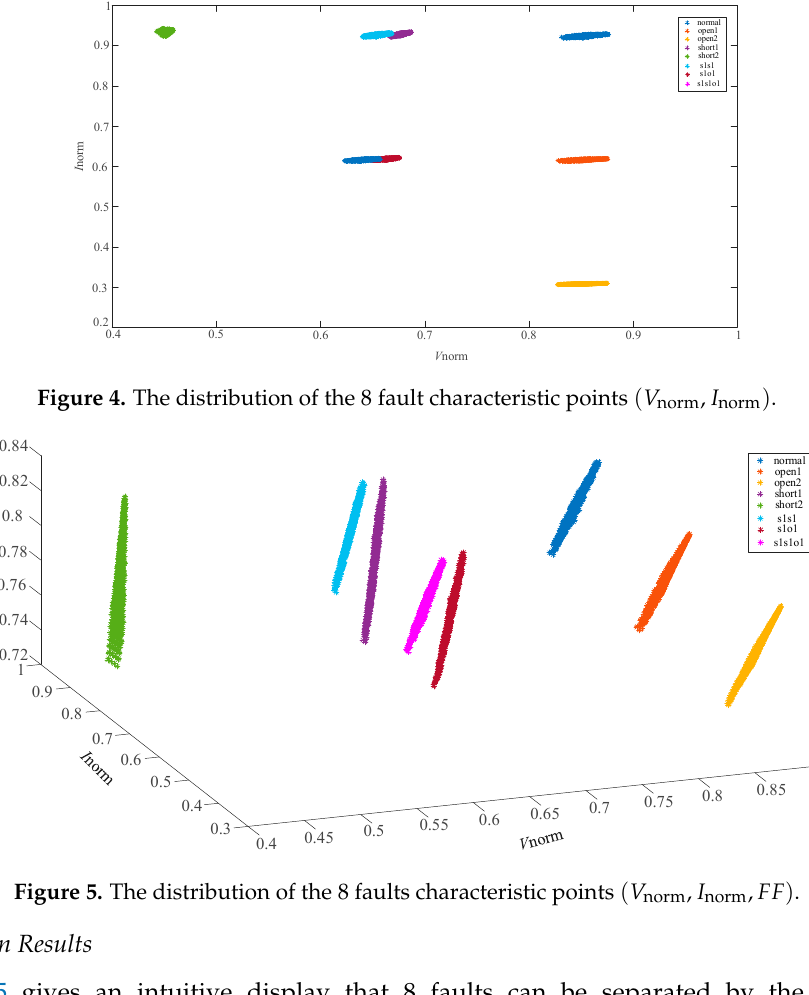
, , V I FF . norm norm